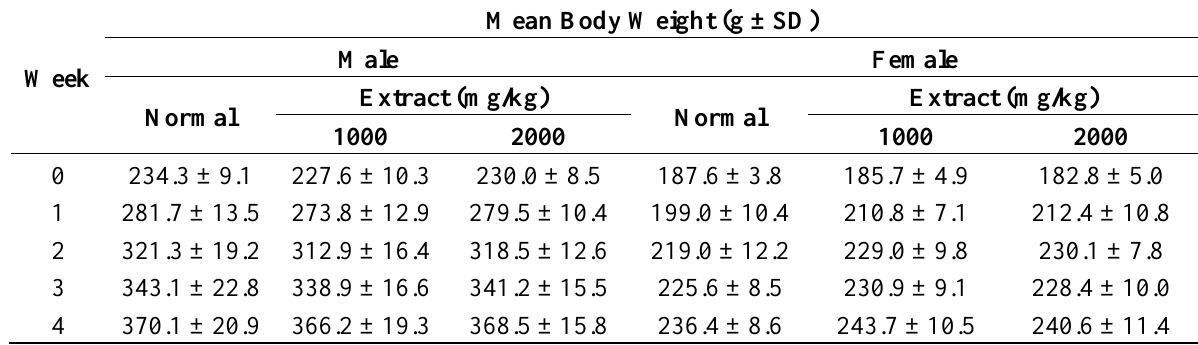
Table 1. Mean body weight of rats after 28 days treatment with A. sinensis